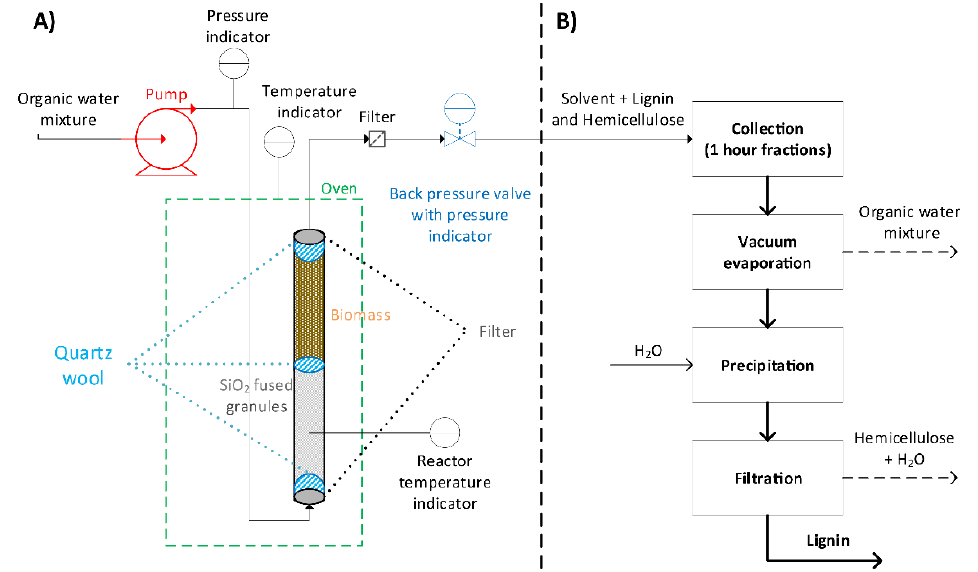
Figure 2. Schematic overview of the extraction procedure, showing ( A ) the developed flow-through setup and ( B ) the workup procedure for lignin isolation.